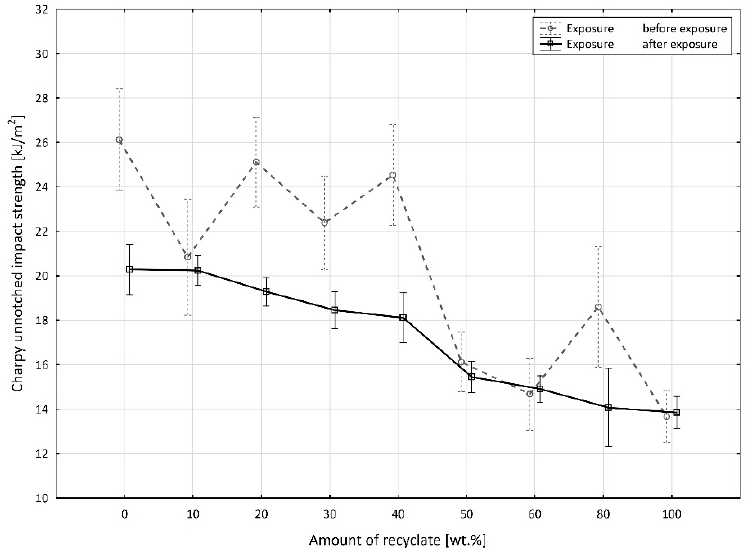
Figure 11. Dependence of the mutual interaction of the amount of recyclate and the exposure of the sample on the value of the unnotched impact strength of PPA .